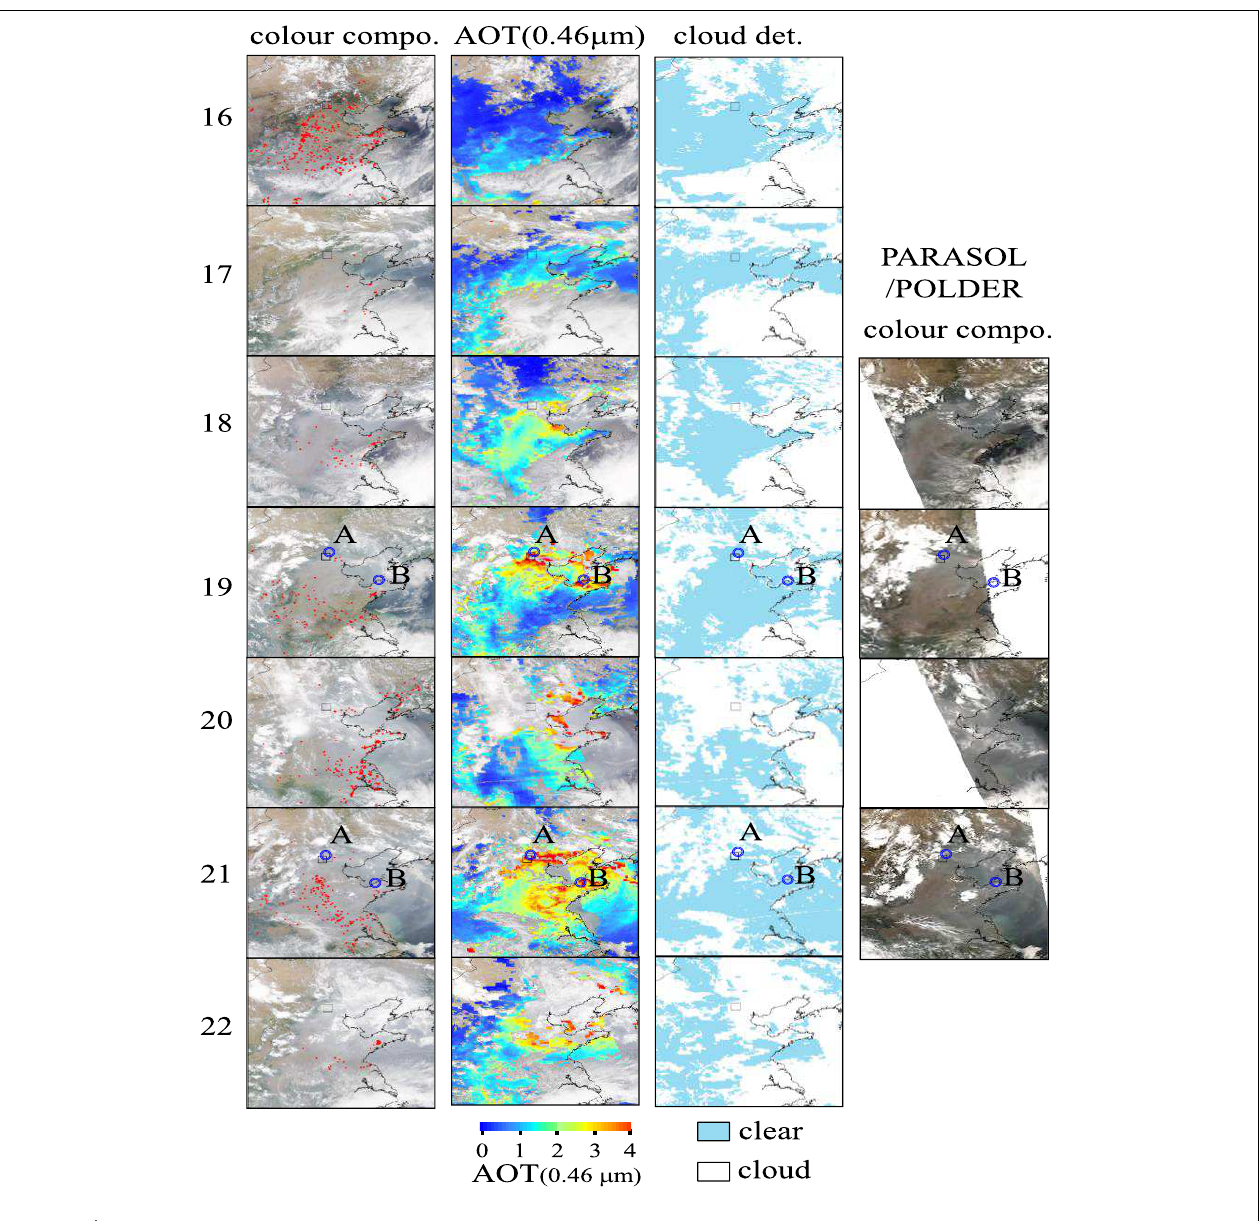
FIGURE 2 | Aqua/MODIS images over east-central China from 16th to 22nd June, 2012, the left three columns presenting color composite images, distribution of AOT (0.46 µ m) and cloud detection (MYD04 L2